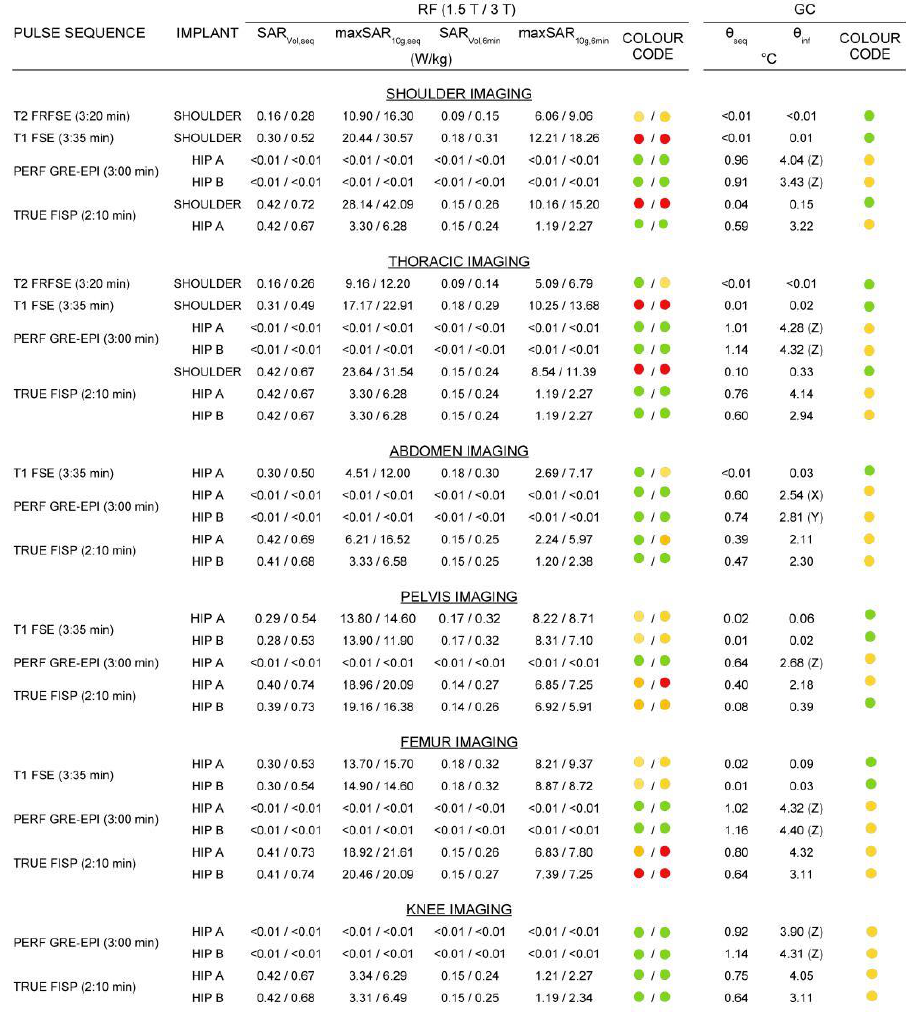
Figure 5. Radiofrequency (RF) and gradient coil (GC)-heating stress evaluation for the scenarios of risk tier 3 or tier 2. Tiers 3, 2 and 1 are associated with red, yellow and green colours, respectively. Finally, the result of a sensitivity analysis of the SAR averages with respect to the RF pulse length is reported in Figure 6. The RF pulse length affected almost linearly the power deposition, with a variation of 30% in the SAR averages for a variation of 30% in the RF pulse length. This analysis was independent of the selected sequence and was per- formed keeping the time – bandwidth product of the pulse modulation constant.